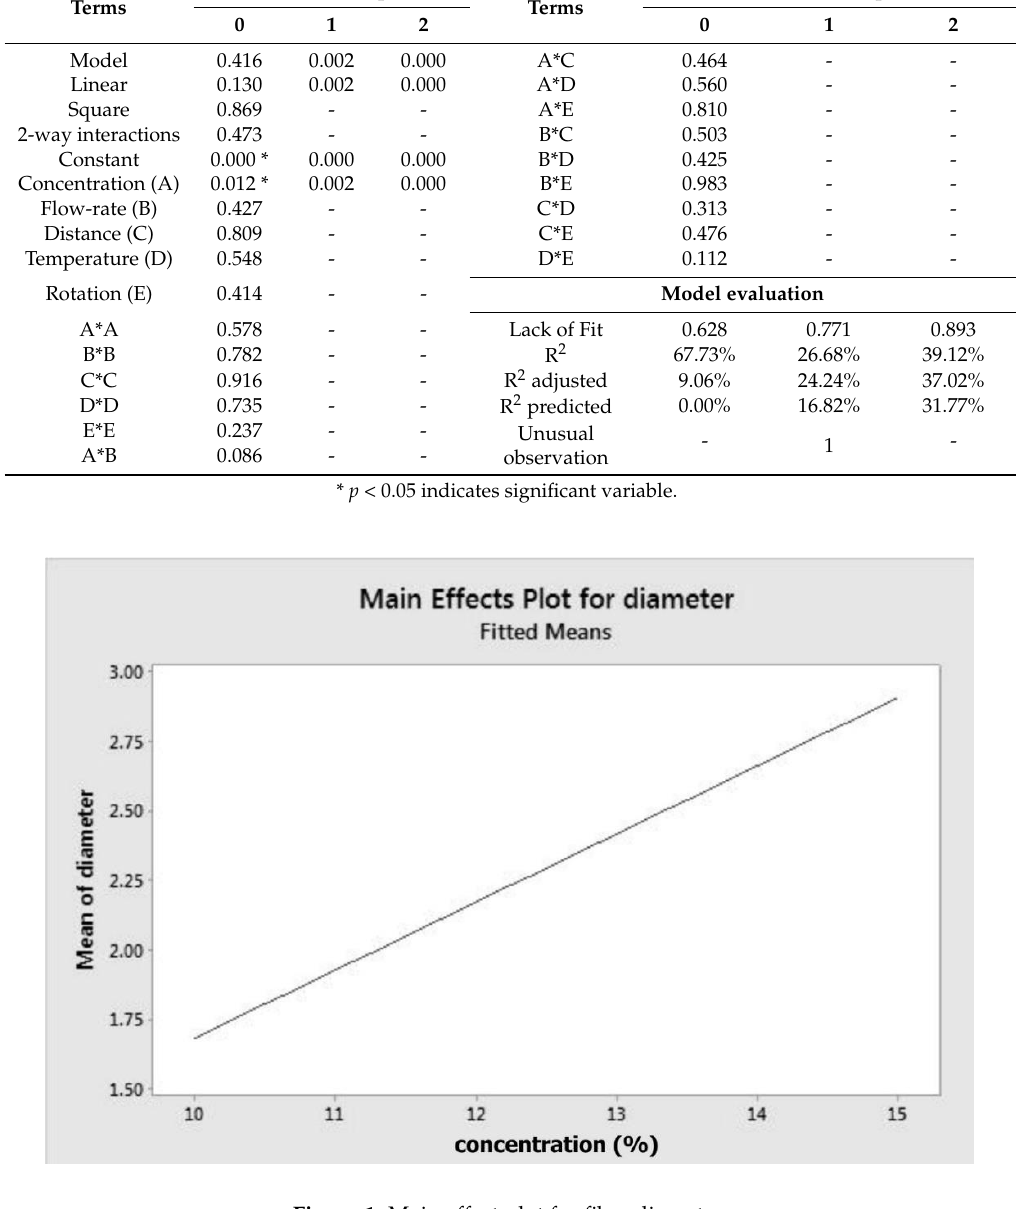
Figure 1. Main effect plot for fibre diameter.